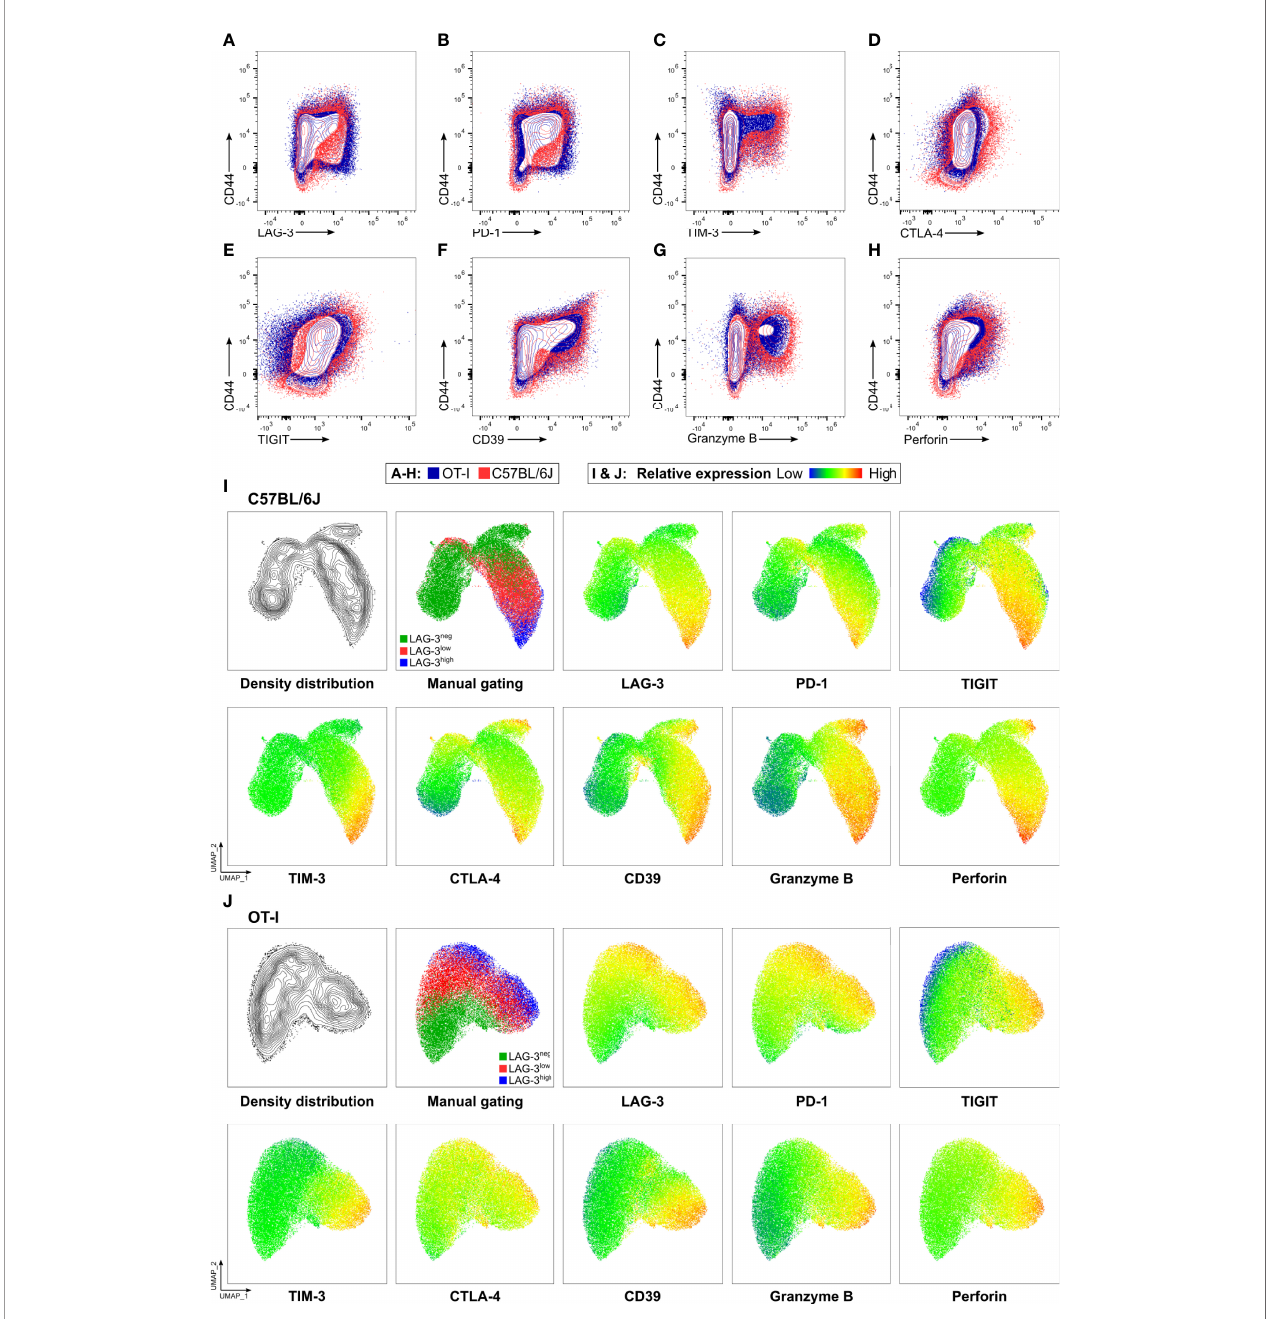
FIGURE 3 | OT-I derived CD8 + CD44 + T cells express co-inhibitory and effector molecules in a similar fashion to C57BL/6J derived CD8 + CD44 + T cells. Exemplary contour showing expression of (A) LAG-3, (B) PD-1, (C) TIM-3, (D) CTLA-4, (E) TIGIT, (F) CD39, (G) GrzB and (H) Perforin on CD8 + T cells relative to CD44 expression. Cells were obtained from the spleens of C57BL/6J (red), and OT-I (blue) mice infected with PbTG 6 days past infection. (I, J) Representative UMAP clustering of CD44 + CD8 + T cells isolated from C57BL/6J and OT-I mice infected with PbTG 6 days post infection showing the density distribution within the plot; classi fi cation into CD44 + LAG-3 neg , CD44 + LAG-3 low and CD44 + LAG-3 high as used throughout the manuscript and relative expression of indicated molecules. Sampled were downsampled to 40.000 cells. UMAP parameters: Distance: Euclidean, Nearest Neighbours: 15, Minimum Distance: 0.5, Number of Components: 2, UMAP v3.1 for